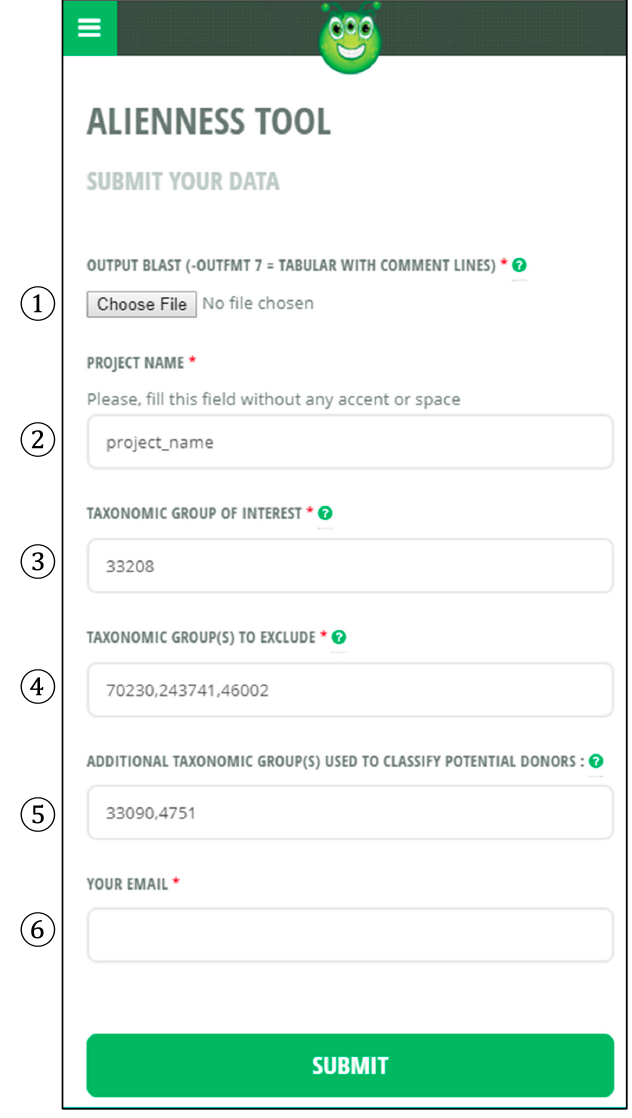
Figure 2. Graphical interface of Alienness to upload BLAST results and input the different parameters. Detailed information on 1–6 is given in the main text.